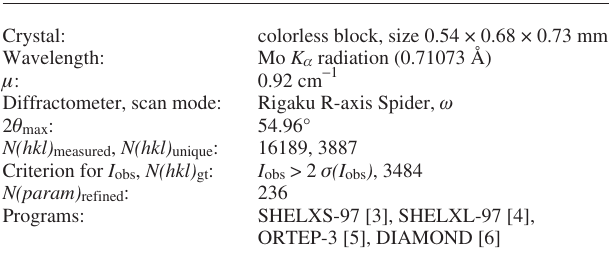
Table 1. Data collection and handling.